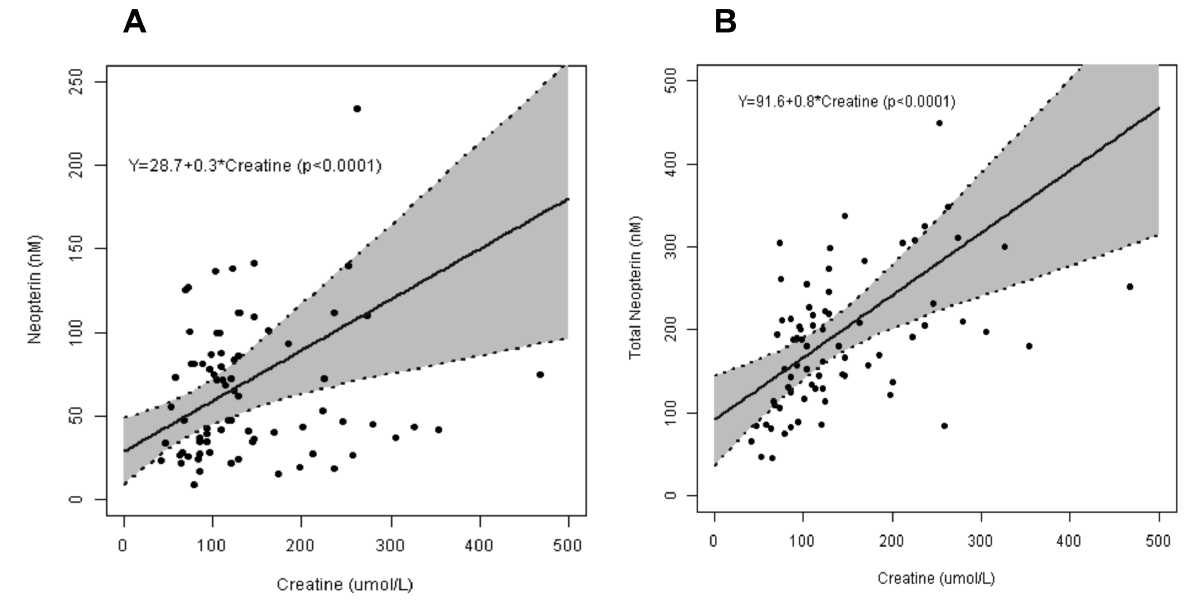
Figure 7: Plasma neopterin (A) and plasma total neopterin (B) correlated with plasma creatinine of sepsis patients. Both neopterin (p<0.0001) and total neopterin (p<0.0001) strongly correlated to plasma creatinine with positive